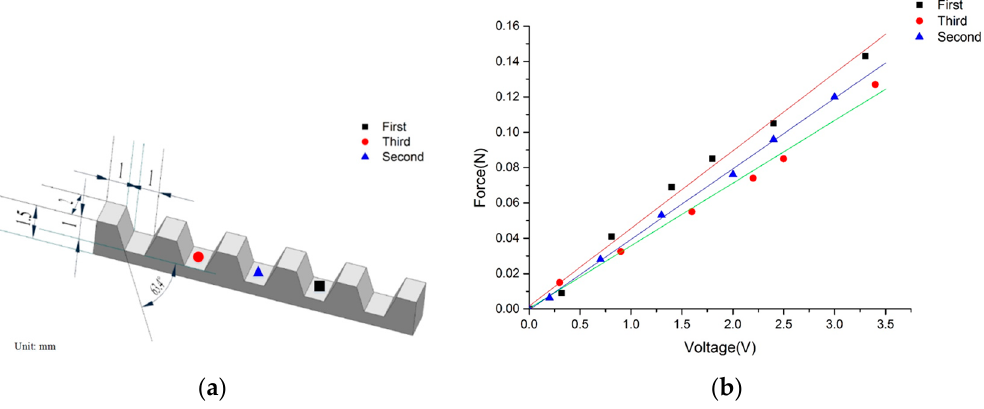
Figure 11. Calibration results of the microforce sensor towards different cell holding grooves ( a ) position of the force's application point; ( b ) relationship between force input and sensor output.